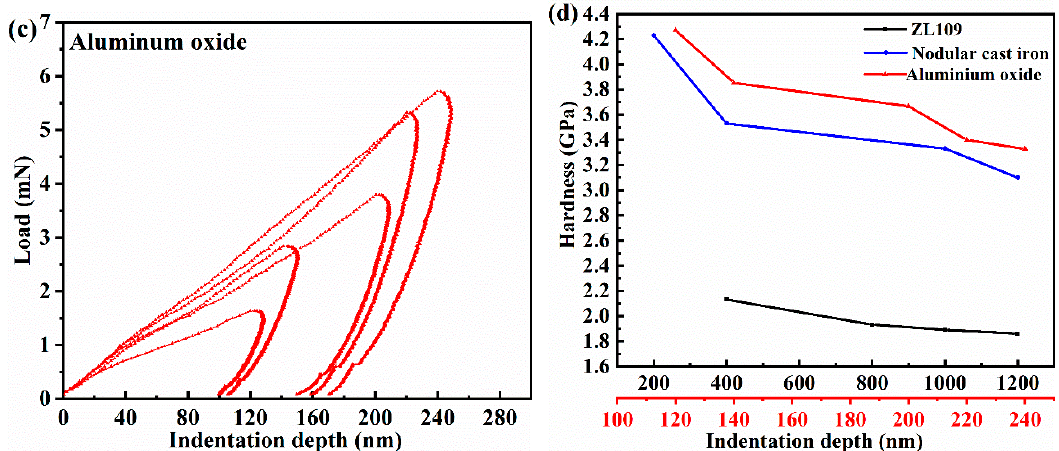
Figure 7. Load-unload curves dependence on the indentation depth for ( a ) ZL109; ( b ) nodular cast iron; and ( c ) aluminum oxide; ( d ) nanoindentation hardness.